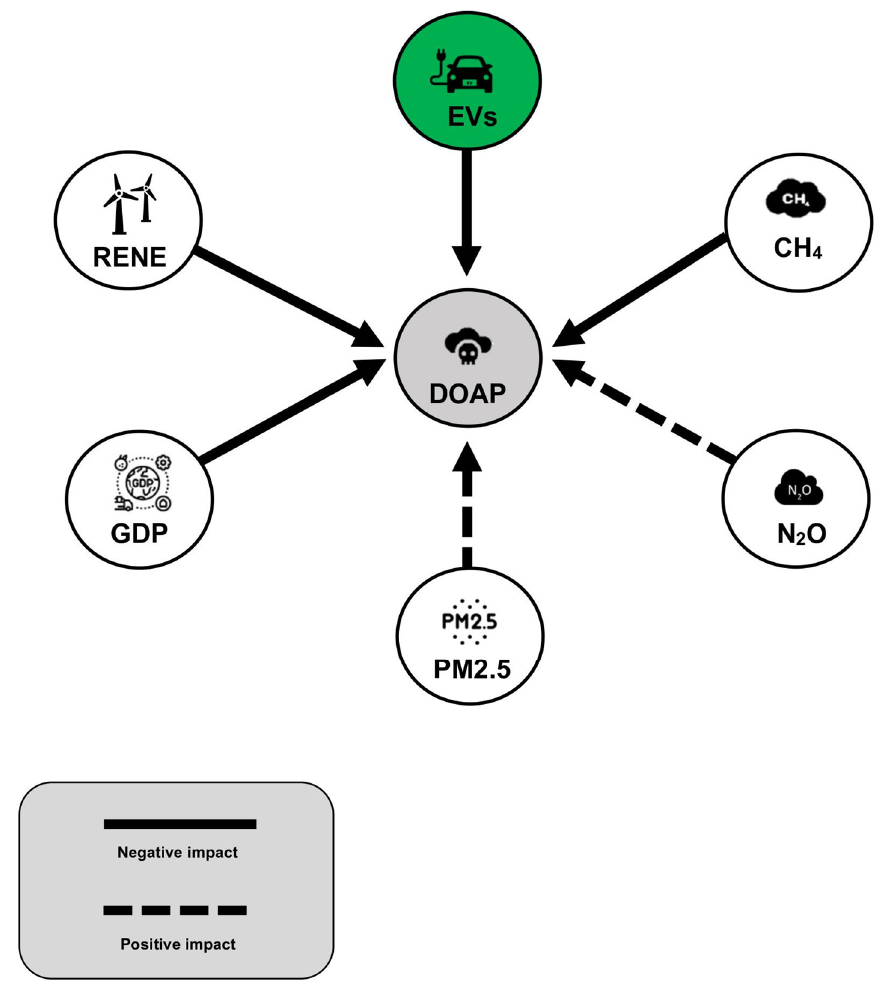
Figure 8. Summary of each variable’s effect. The authors created this figure.